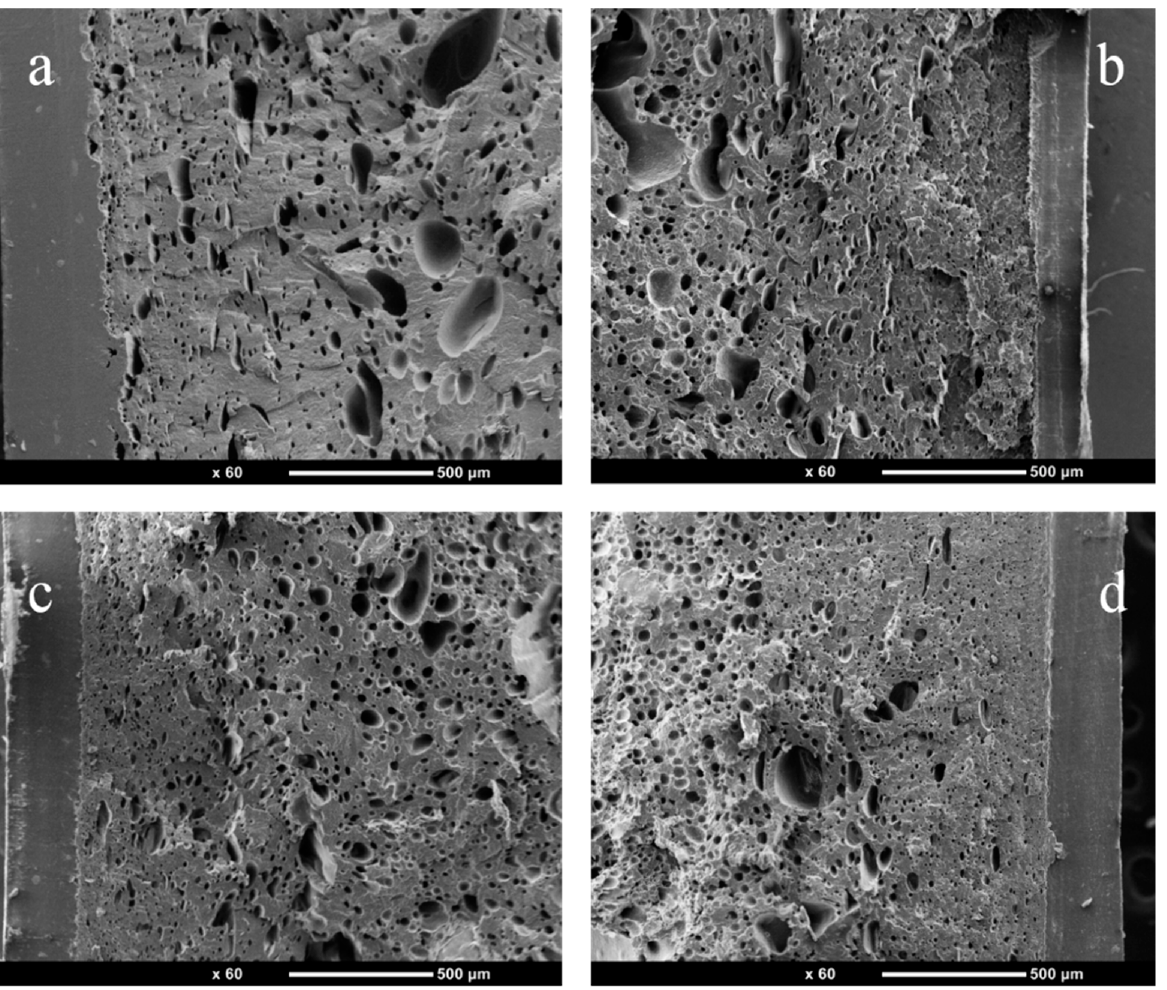
Figure 4. SEM picture of PP/PTFE composite materials with different contents of PTFE using foam injection molding from the skin to the core layer ( a ) PP; ( b ) 1 % PTFE; ( c ) 3 % PTFE; ( d ) 5 % PTFE.